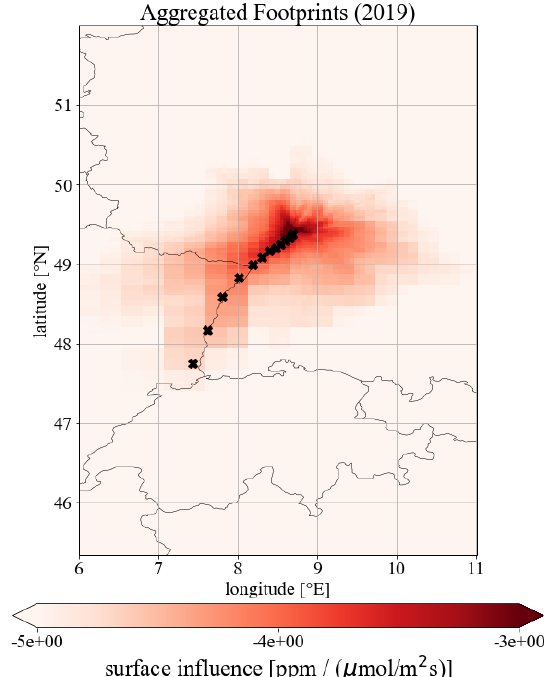
Figure 6. Aggregated hourly footprints in 2019, calculated with the SSI approach for the observation site Heidelberg at 30m height a.g.l. The black crosses indicate the locations of the 12 pseudo power plants, which are located at distances of 5, 10, 15, 20, 25, 30, 40, 50, 70, 100, 150 and 200km from the Heidelberg observa- tion